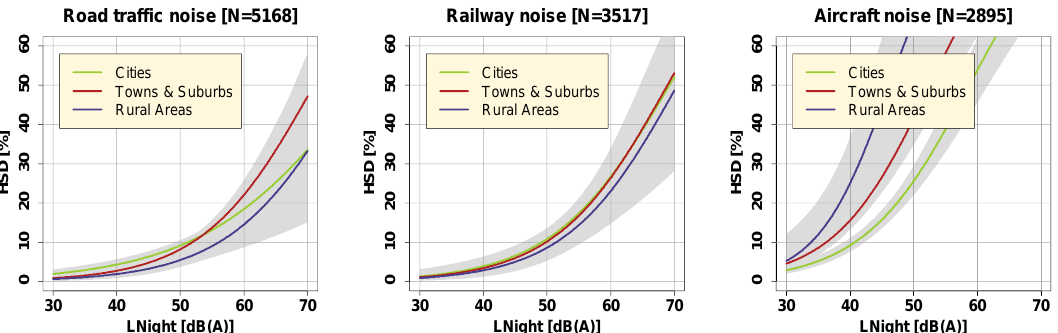
Figure 7. Exposure-response relationships for road traffic (left), railway (middle), and aircraft noise (right), for different degrees of urbanization in the municipality of the respondent’s dwelling unit, including 95% (partly overlapping) confidence intervals (shaded areas). Curves are based on the adjusted model in the full sample with covariates centered on the mean.